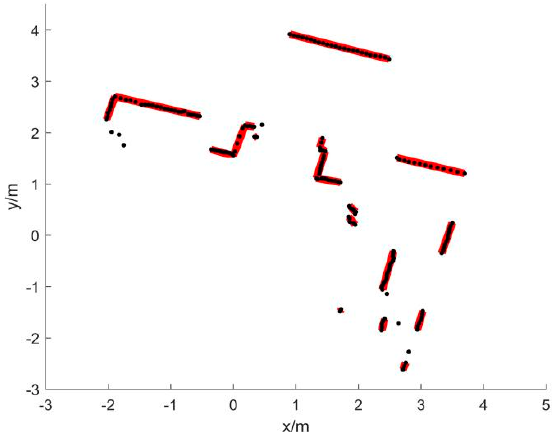
Figure 3. Simulation of line feature extraction algorithm.